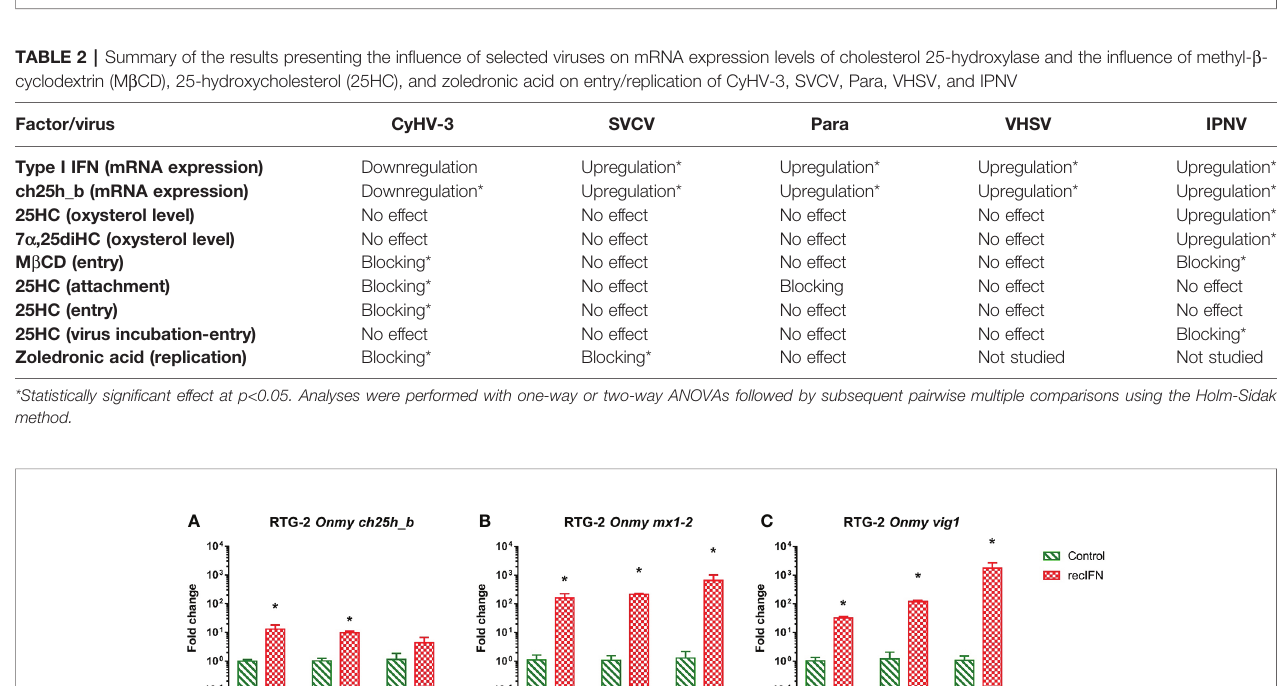
FIGURE 6 | Effect of the incubation of carp cells with 25-hydroxycholesterol (25HC) for 8h prior to (PRE) or 8h post (POST) infection with CyHV-3 on the mRNA transcription of CyHV-3-speci fi c genes (A) ORF71, (B) ORF79, and (C) ORF92 as a surrogate for virus replication. Data presented as a bar indicating mean normalized copy numbers (+SD) from n = 3 replicates. * indicates a statistically signi fi cant difference at p<0.05 between control and the treatments. Analysis was performed with two-way ANOVA with treatments and time points as factors. The ANOVA was followed by subsequent pairwise multiple comparisons using the Holm-Sidak method.